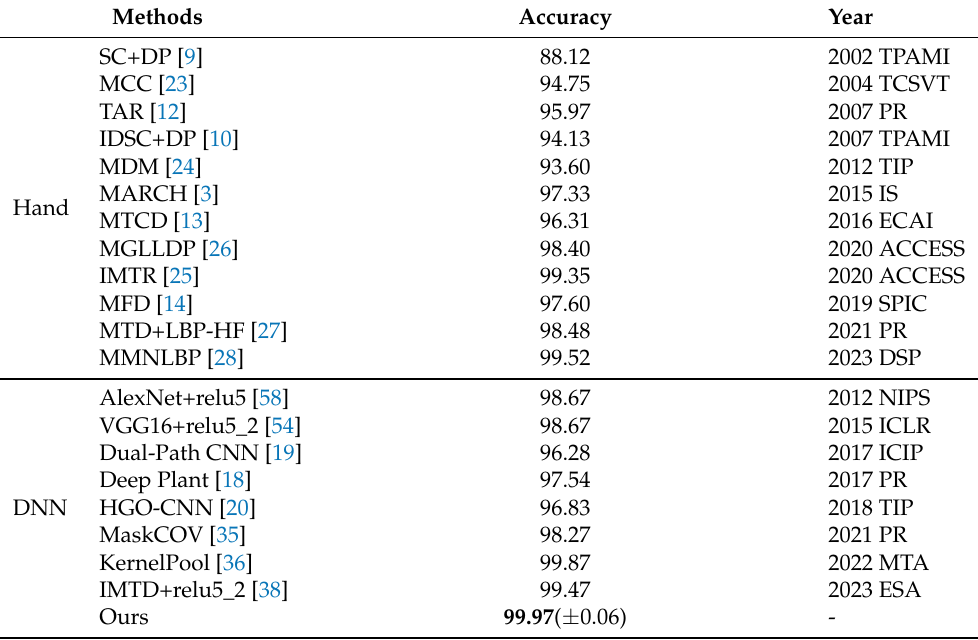
Figure 7. Example images for Swedish, Flavia, MEW2012, ICL datasets. Table 3. Classification accuracy (%) comparison on Swedish dataset with identical